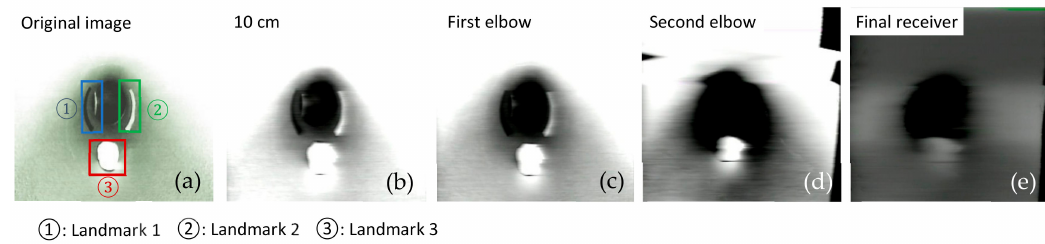
Figure 6. Analog image transmission with visible light in the empty